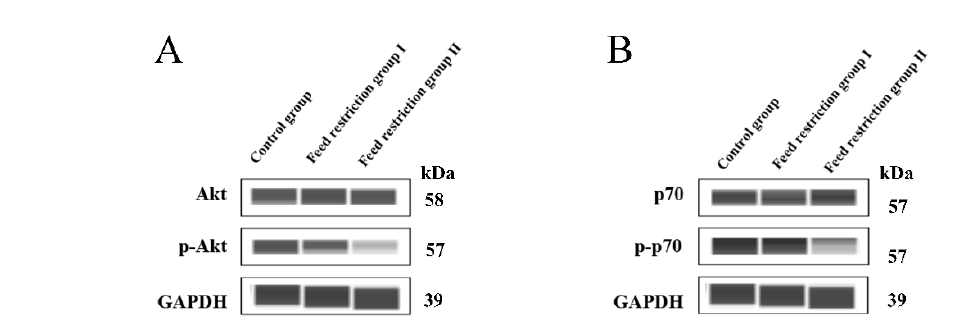
Figure 2. Effect of feed restriction on the phosphorylation level of Akt and p70. ( A ) the Akt, p-Akt, and GAPDH protein expressions in different groups; ( B ) the p70, p-p70, and GAPDH protein expressions in different groups.